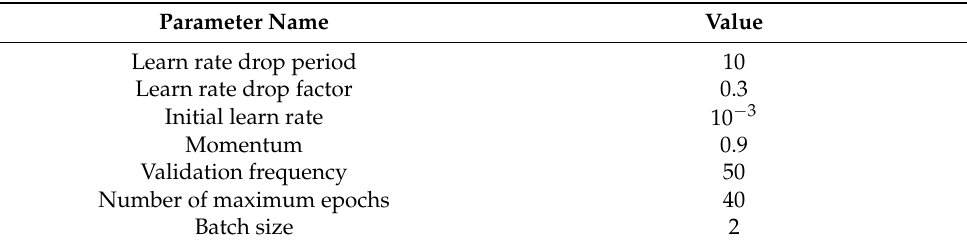
Table 2. Training options for semantic segmentation.